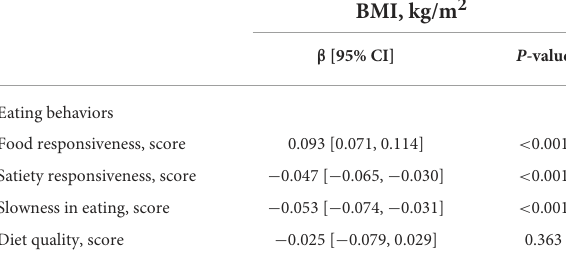
TABLE 3 Associations between the body mass index and eating behaviors and diet quality in school-aged